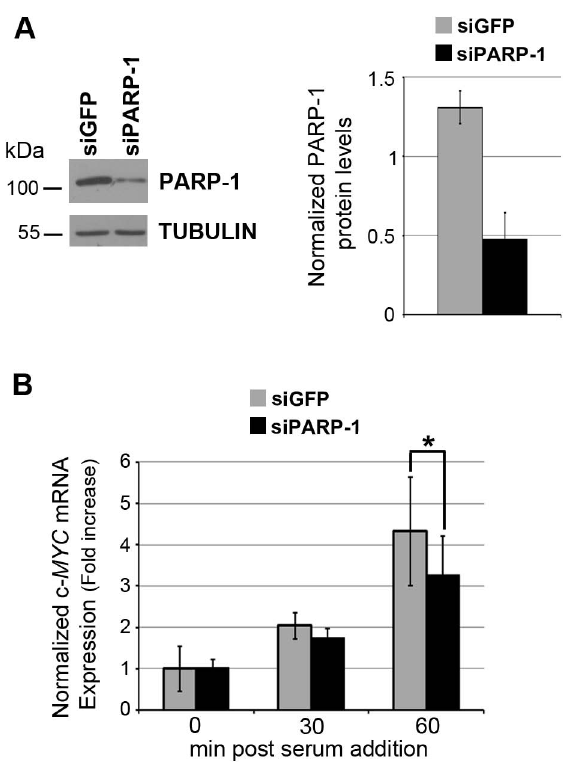
Figure 1. PARP-1 is required for the normal accumulation of c- MYC mRNA upon serum stimulation. A, PARP-1 levels assessed by western blot in quiescent FB1329 fibroblasts transfected with the control (siGFP) or the specific (siPARP-1) siRNAs. TUBULIN was used as a loading control. Left panel shows the results of a representative experiment; right panel shows the averages and the Standard Deviations (SD) of densitometric values of PARP-1 signals normalized respect to TUBULIN, derived from three independent experiments. B, c- MYC expression assayed by RT-qPCR in quiescent (0) and serum- stimulated (for 30 or 60 minutes) siRNA-trasfected fibroblasts. c-MYC expression levels were normalized relatively to TBP expression and reported as fold increase respect to the control quiescent sample. The error bars represent the Standard Deviation of three biological replicates. Statistical significance: *: P , 0.05 (Student’s t test).